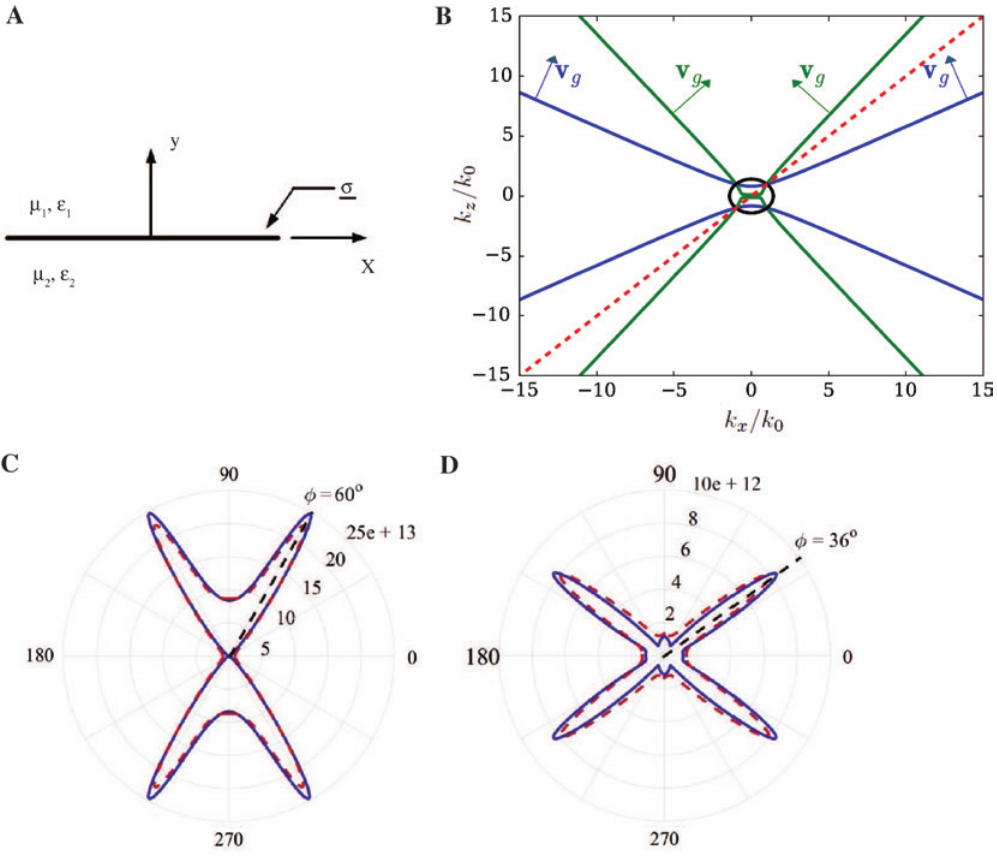
Figure 5: Anisotropic and hyperbolic metasurfaces. (A) Anisotropic surface with conductivity tensor σ at the interface of two isotropic materials. (B) Equifrequency contours, ω (k) = const, for hyperbolic metasurfaces having σ mS (green hyperbola). For comparison, the isotropic case for σ